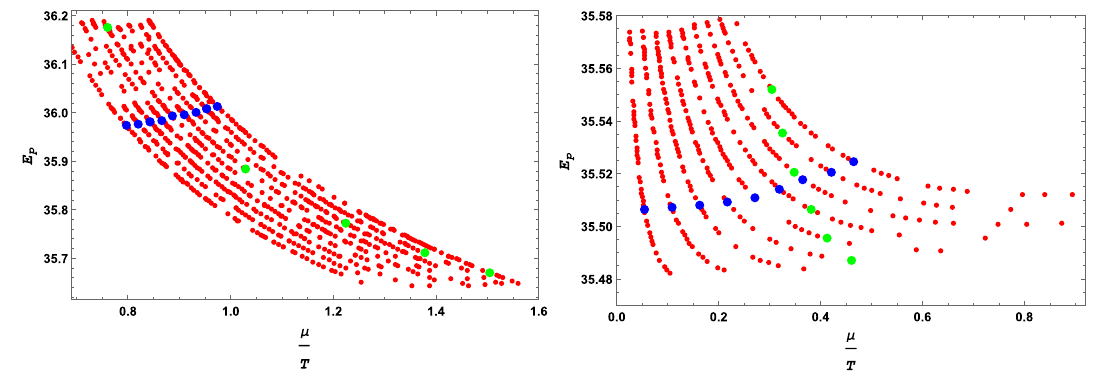
Fig. 5 Left: the EoP with respect to μ for l = 0 . 5 and l (cid:3) = 0 . 1 in the In left (right) figure the green points show the configuration at fixed T μ = 1 . 077 ( μ = 0 . 194) and blue points show the configuration at fixed field theory with critical point corresponding to metric (12). Right: the T = 1 . 20 ( T = 0 . EoP with respect to μ for l = 0 . 5 and l (cid:3) = 0 . 1 in the field theory with T non-zero chemical potential corresponding to metric (22) with d = 3.